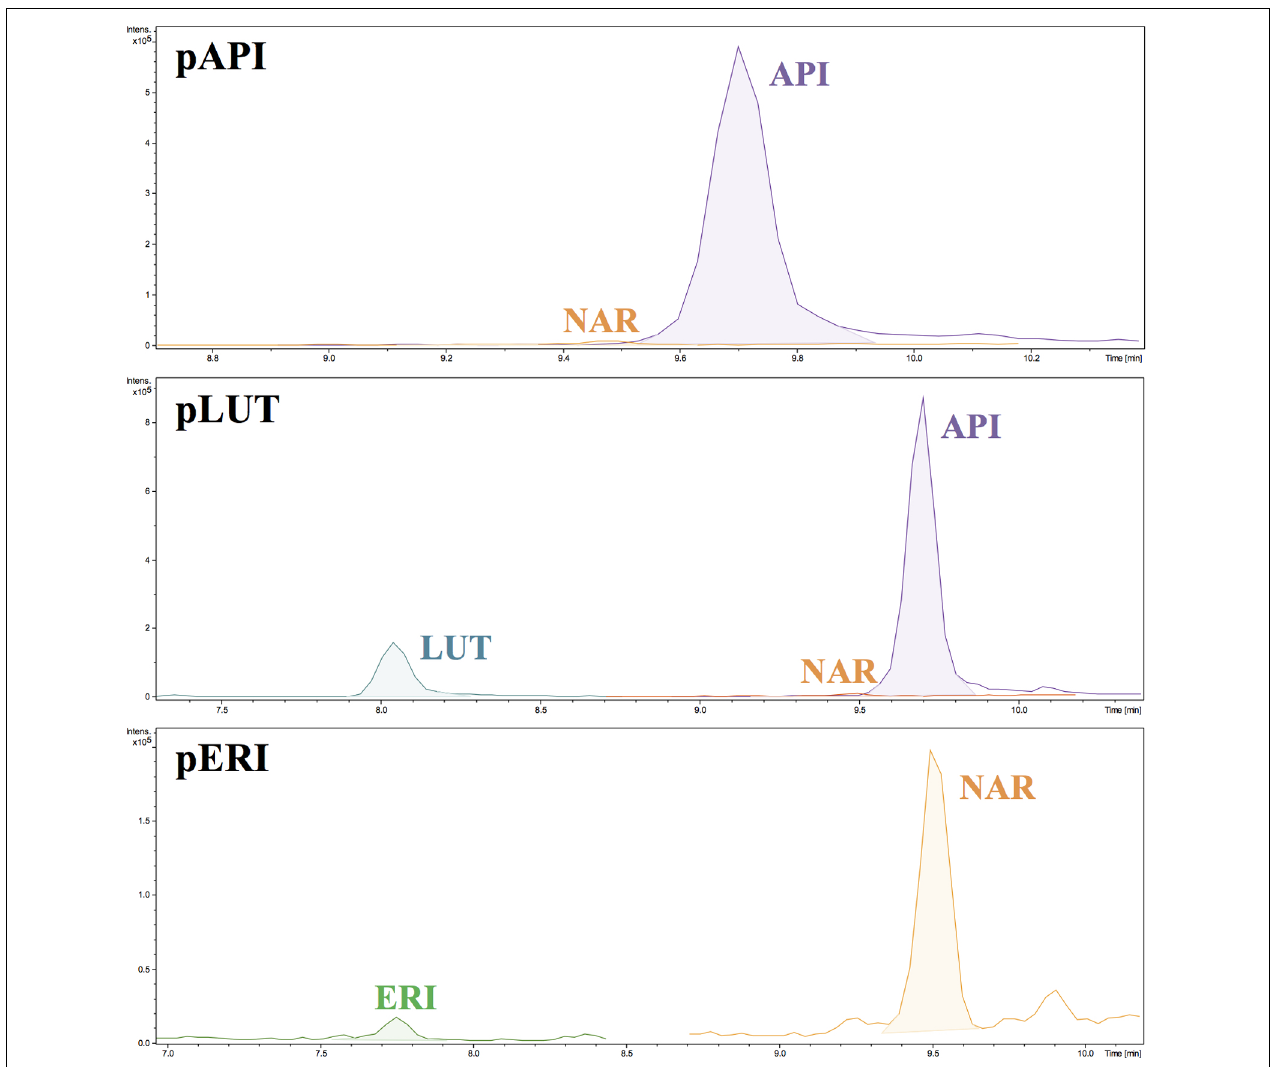
FIGURE 2 | HPLC–MS chromatograms showing the m/z peaks corresponding to naringenin (NAR), apigenin (API), luteolin (LUT), and eriodictyol (ERI). In the corresponding S. albus strains.